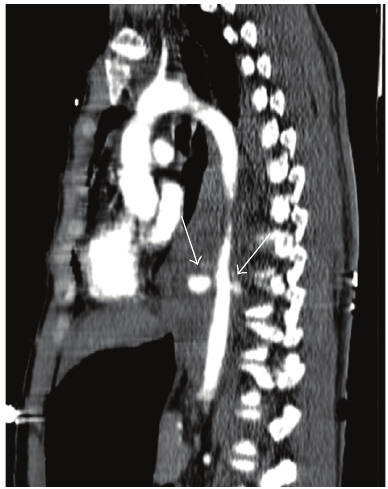
Figure 3: Contrast-enhanced sagittal chest CT using the mediasti- nal window settings demonstrates active contrast material leak from the hematoma located in the posterior mediastinum, and this is considered as aortic